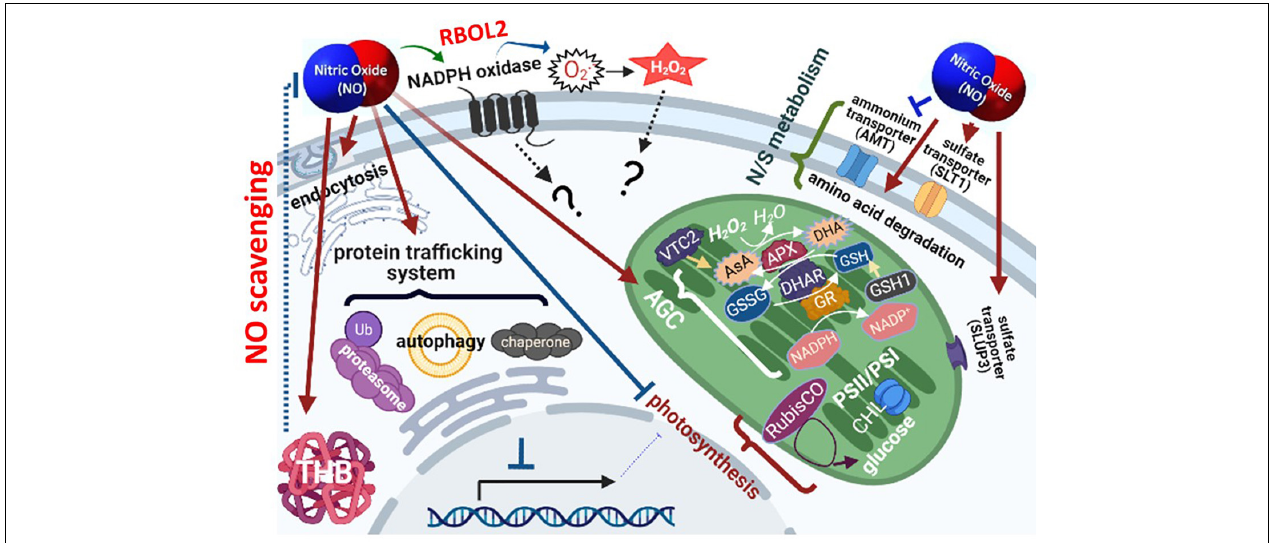
FIGURE 12 | Schematic model of nitric oxide (NO) responsive molecular events in Chlamydomonas reinhardtii . The orchestrated implementation of metabolic processes in response to NO is achieved by 1. the modulation of NADPH oxidase (RBOL2) and/or ROS signaling pathway for the regulation of downstream metabolisms, 2. reduction of NO amount via scavenging elements, 3. transient inhibition of photosynthesis together with the induction of the antioxidant defense system and modification of the redox state to prevent oxidative stress, 4. transient attenuation of transcriptional and translational capacity accompanying with the upregulation of the protein trafficking system (ubiquitin, SNARE, and autophagy) and molecular chaperone system for dynamic regulation of protein homeostasis and function, and 5. enhancement of amino acid catabolism and nitrogen/sulfur availability.